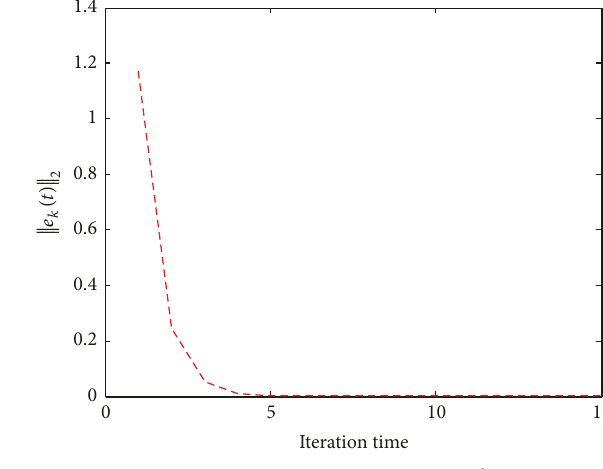
Figure 2: Tracking errors in the sense of 𝐿 2 -norm.